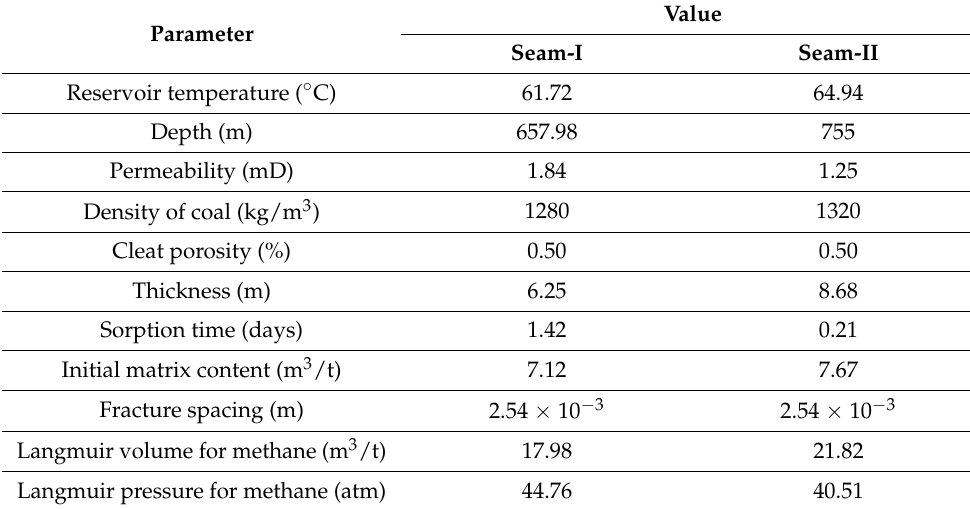
Table 1. Input parameters used for simulation